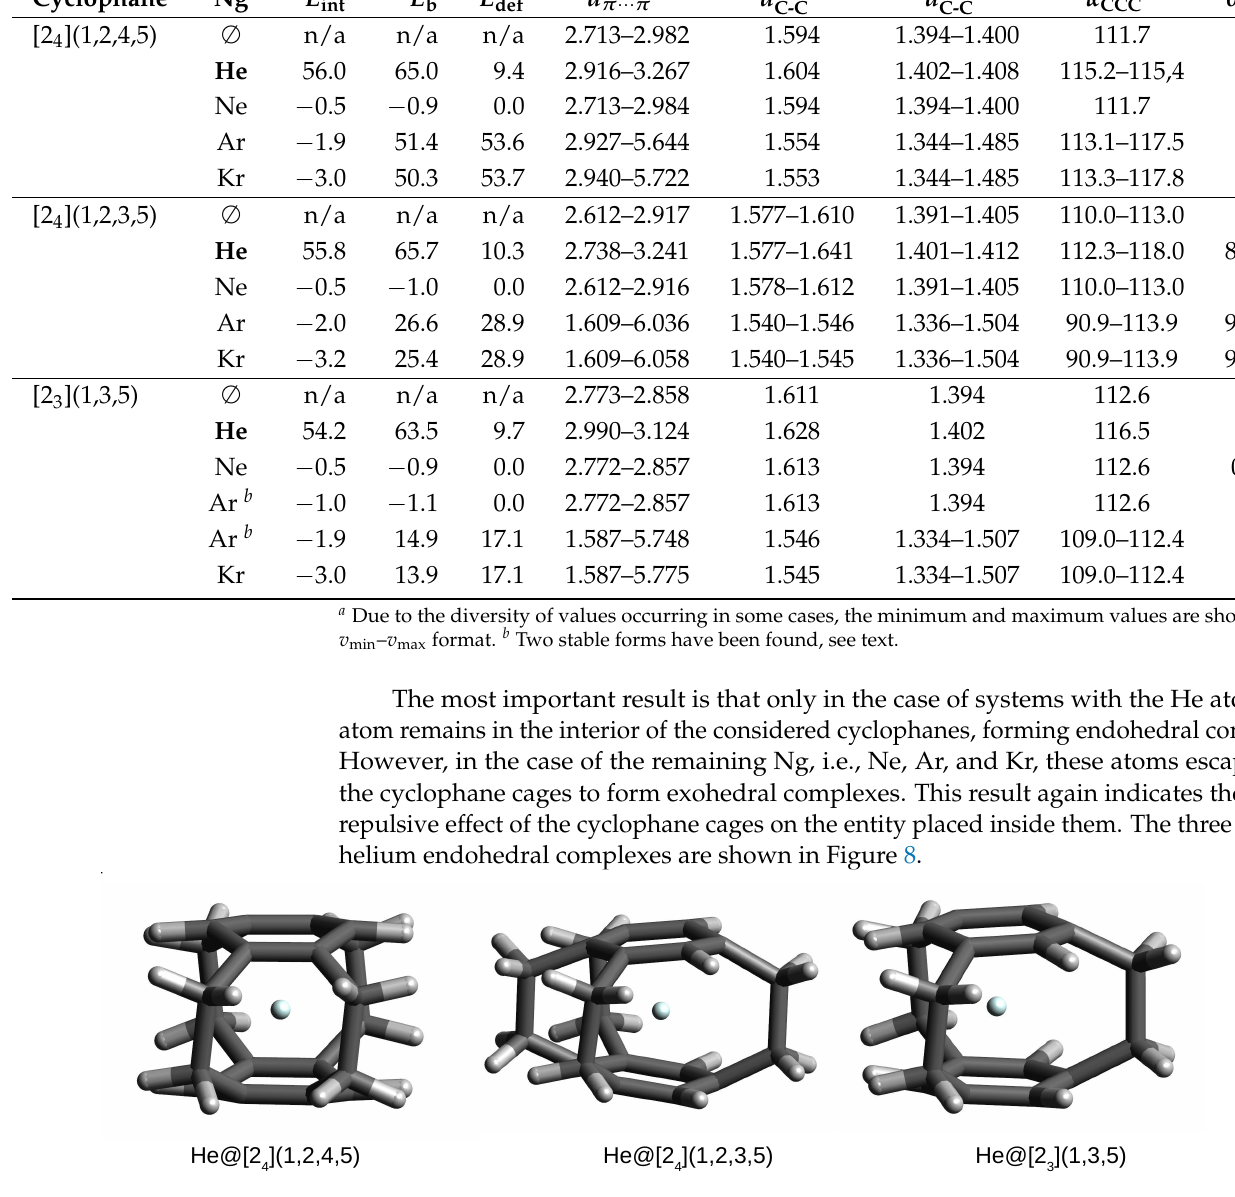
Figure 8. Structures of some He@cyclophane